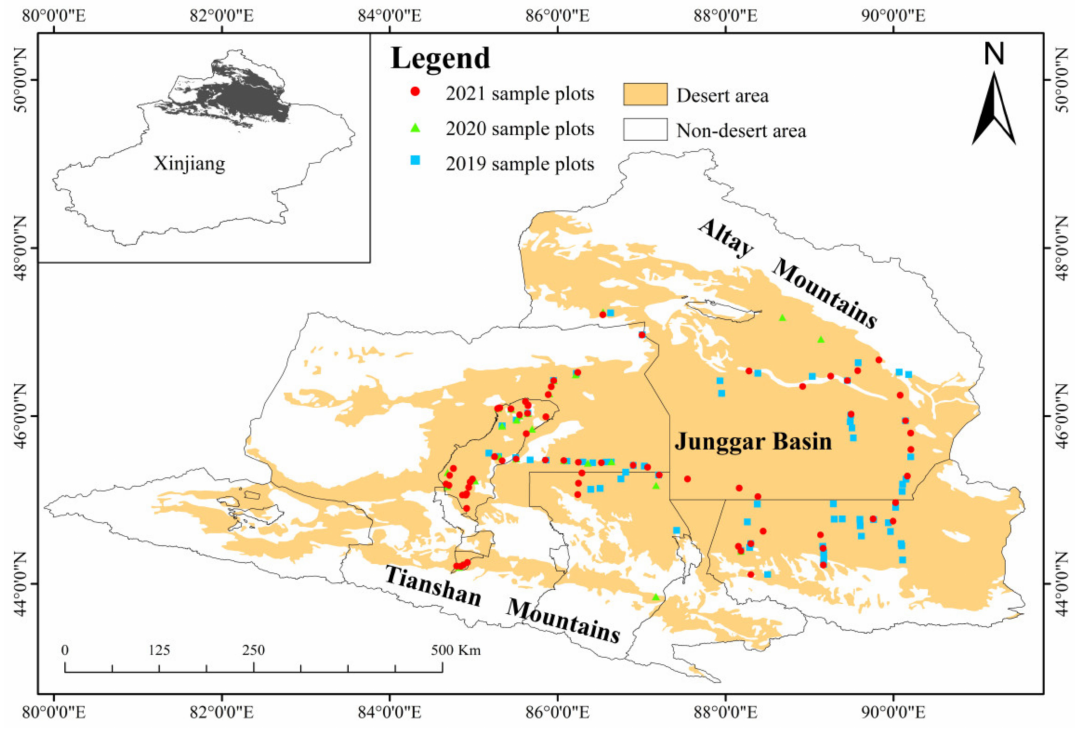
Figure 1. Location of sample plots for vegetation coverage in the Junggar Basin (obtained by UAV) in